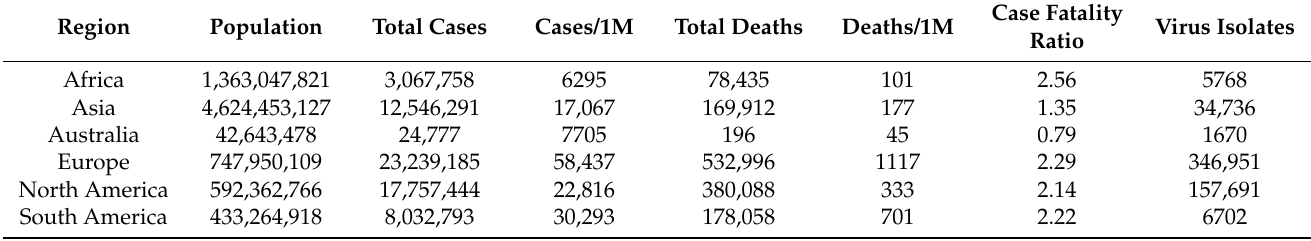
The clades for 553,518 SARS-CoV-2 genome sequences from different world conti- nents were identified. The clades frequencies are shown in Figure 1A. The clades having the highest frequencies among continents were G, GH and GR. The highest frequencies for G clade were in South America and the predominance of clade GH in North America. The clades GR predominated in Asia (Supplementary Table S1).